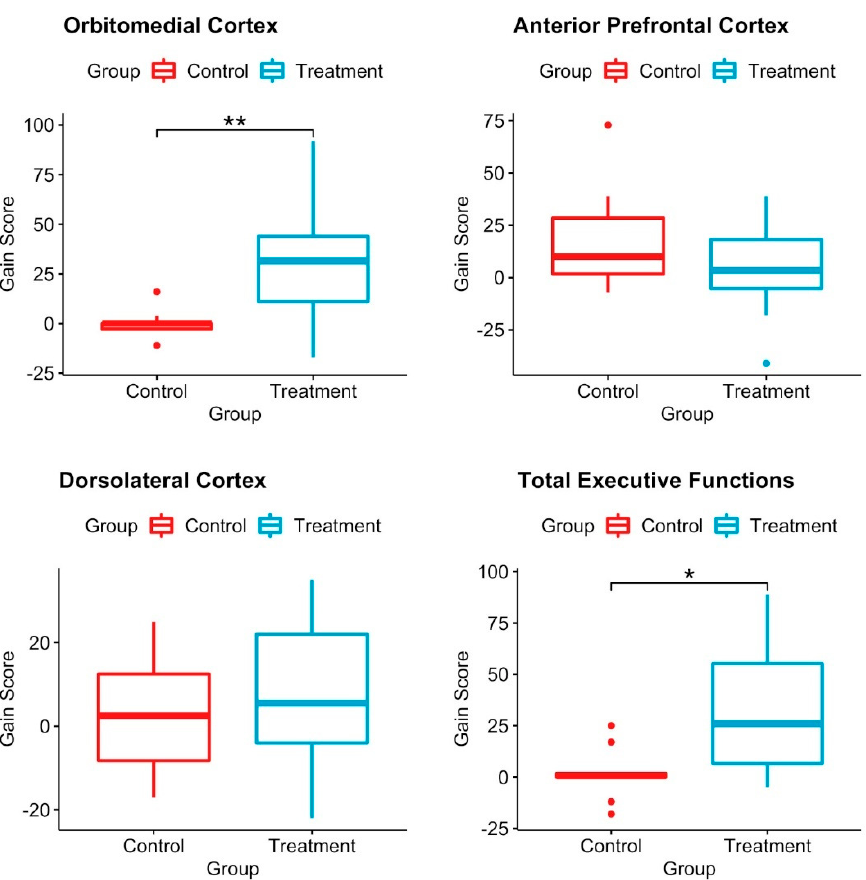
Figure 4. Boxplot of the gain scores for the diagnosis variable by group. Box plots depict the differences between pretest and posttest gain scores in the control and LEGO ® -based therapy groups. There were significant differences between groups in the orbitomedial cortex and in the total executive functions. Wilcoxon test; * p ≤ 0.01; ** p ≤ 0.001. Control n = 10; treatment n = 14.